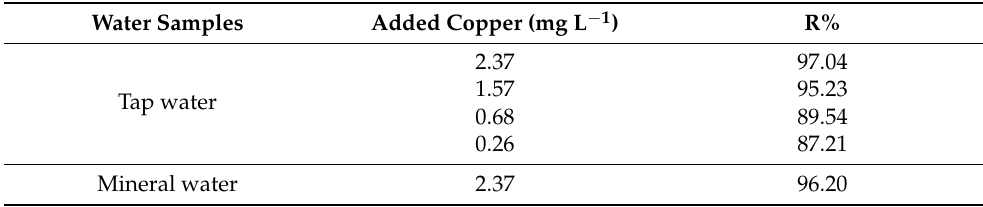
Table 3. Recovery percentages of tap and mineral water samples spiked with Cu cations. Water